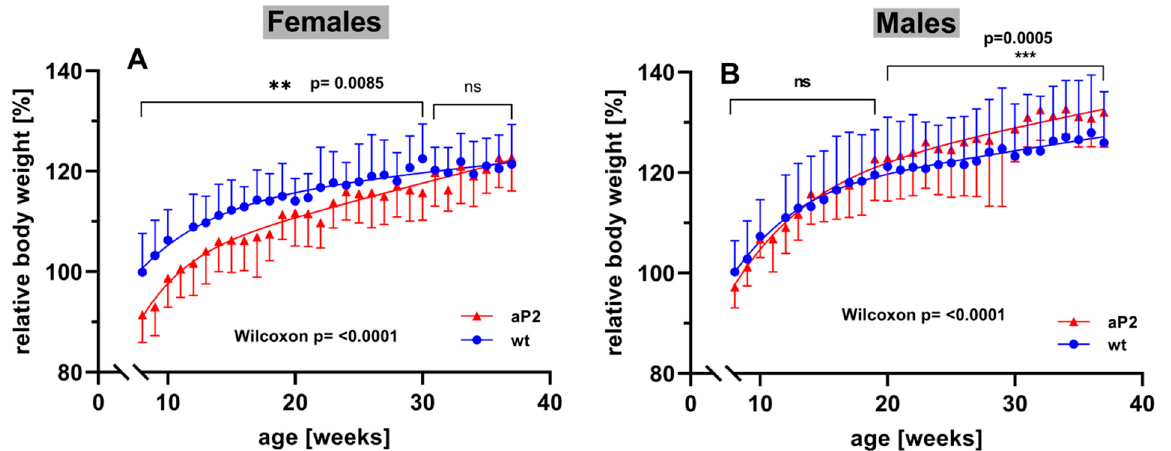
Figure 8. Body-weight kinetics of aP2-ALOX15 mice and corresponding wildtype controls. Female and male aP2-ALOX15 mice (n = 10 of either sex) and wildtype control animals (n = 10 of either sex) were grouped in separate cages (a single cage for each gender and sex, four cages altogether) and received water and standard chow diet ad libitum . Individual body weights were determined once a week. The mean of the body weights of the wildtype individuals entering the experiments (8 weeks old) was set at 100%, and the relative body weights of all individuals were calculated throughout the entire time course of the experiment. ( A ) female individuals, ( B ) male individuals. ns, statistically not significant, ** statistically significant with p < 0.01, *** statistically significant with p < 0.001